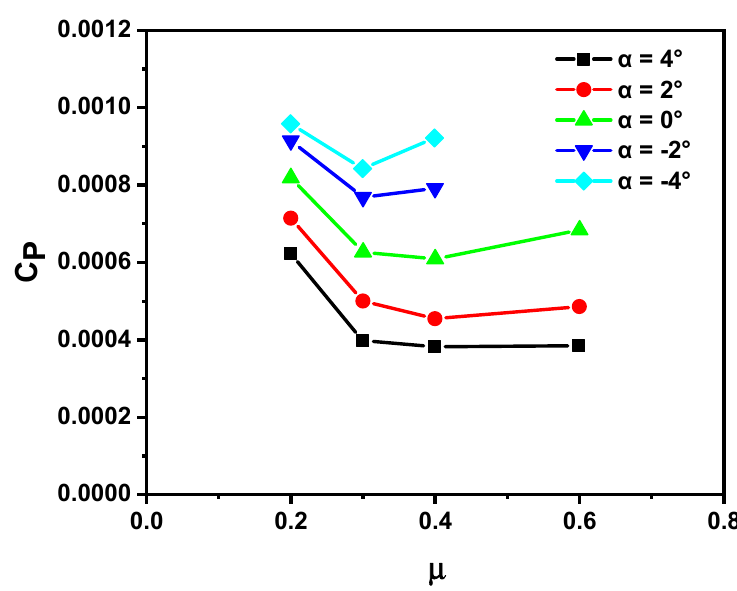
Figure 12. Power coefficient (C P ) as a function of the advance ratio ( μ ), 1100 rpm.